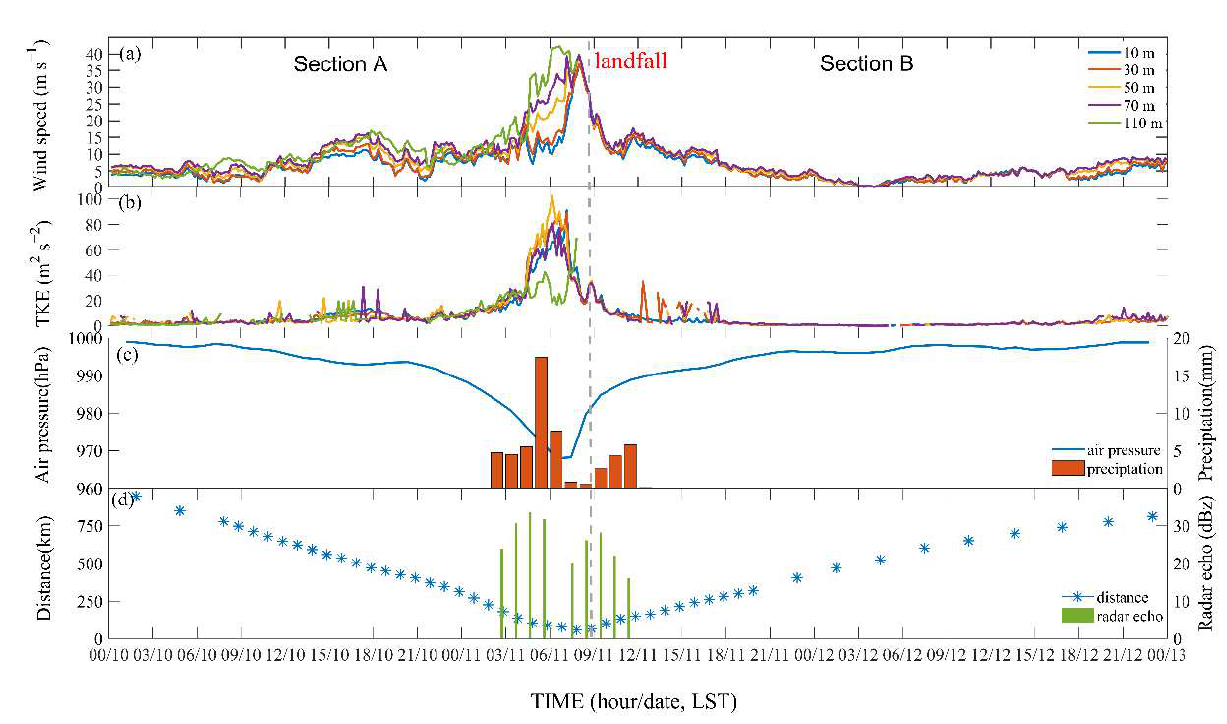
Figure 8. ( a ) Time-series of the 10-min averaged wind speed and ( b ) turbulent kinetic energy (TKE), ( c ) air pressure of the typhoon center and precipitation during landfall, and ( d ) distance of the typhoon center to the tower and radar reflectivities (dBz) observed nearby flux towers from 10 to 12 July (distance data are from http://www.typhoon.gov.cn/, accessed on 1 January 2020).